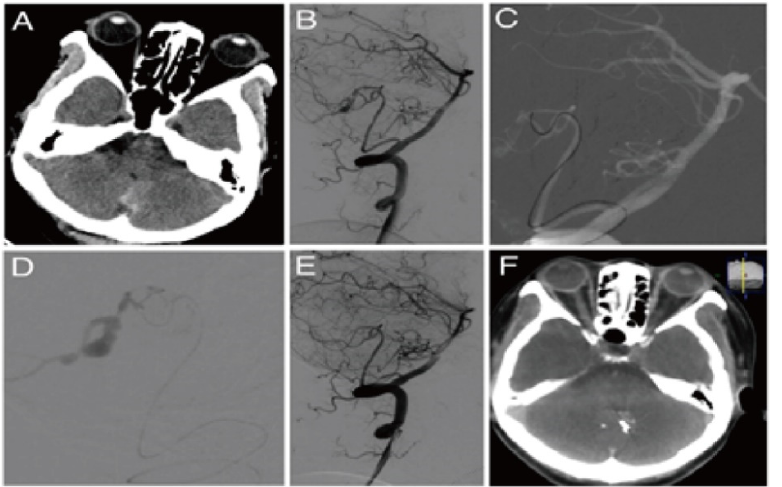
Figure 1. Moyamoya disease with a peripheral hemorrhagic aneurysm. ( A ) Preoperative CT revealed periventricular and ventricular hemorrhage. ( B ) Left internal carotid arteriography revealed smoky vascular hyperplasia with a false aneurysm at the end of the lenticulostriate artery. ( C ) The parent vessels were too tortuous and slender for super-selection. A Marathon microcatheter was located at the beginning of the parent artery. ( D ) Glubran was used to block the parent artery with satisfactory diffusion to the distal aneurysm cavity. ( E ) After the embolization, the aneurysm and parent artery disappeared on arteriography. ( F ) Postoperative CT revealed that the position of the glue coincided with the location of a brain hemorrhage.